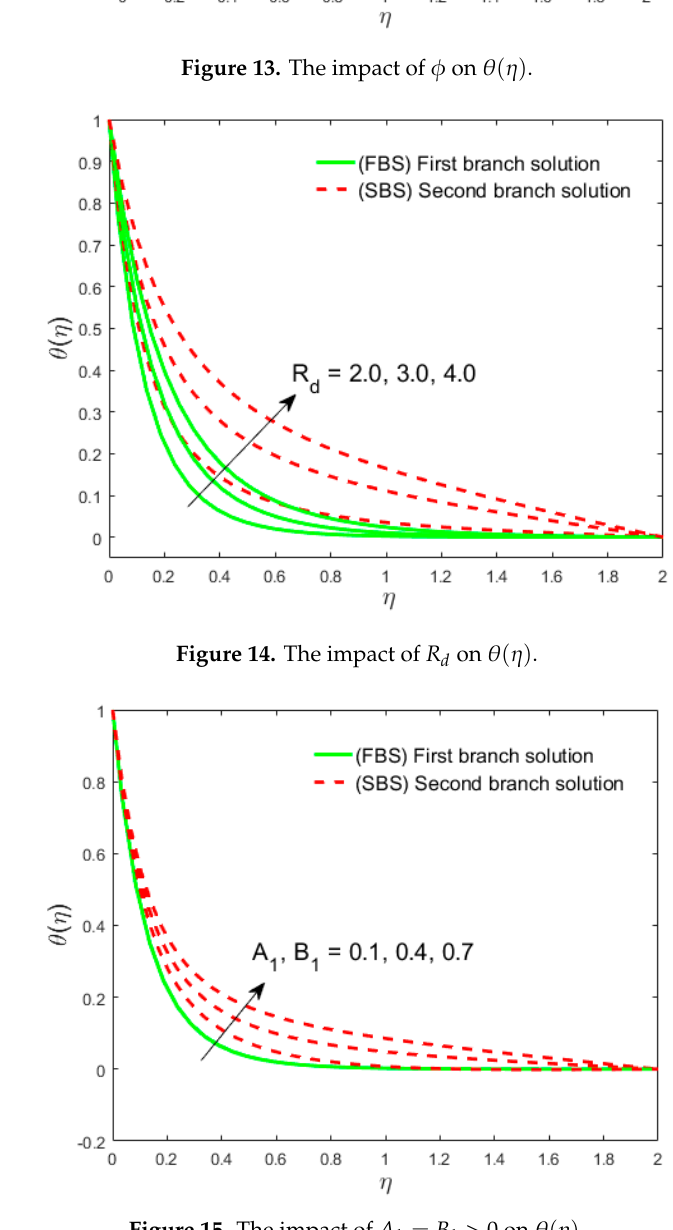
Figure 15. The impact of A 1 = B 1 > 0 on θ ( η )